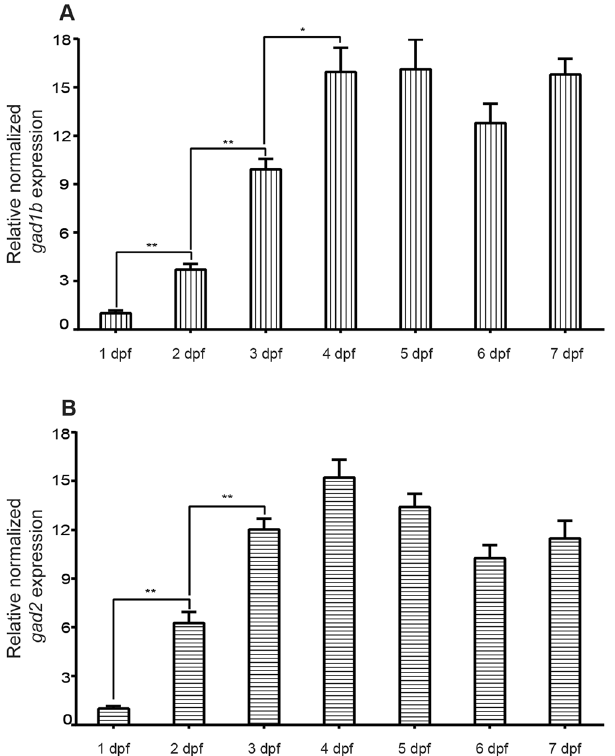
Figure 1. Developmental gad1b and gad2 expression by qPCR. Gene expression levels were quantified relative to reference gene elongation factor 1 alpha ( elf α ), and 18s ribosomal RNA ( 18s ) expression by ΔΔ Cq method. Zebrafish larvae samples from 1–7 dpf are shown. Results for each gene are expressed as mean ± s.e.m. of three experiments performed in triplicate. p-values calculated using Student’s unpaired t-test ( * p ≤ 0.05). ( A ) Developmental expression of gad1b . ( B ) Developmental expression of gad2